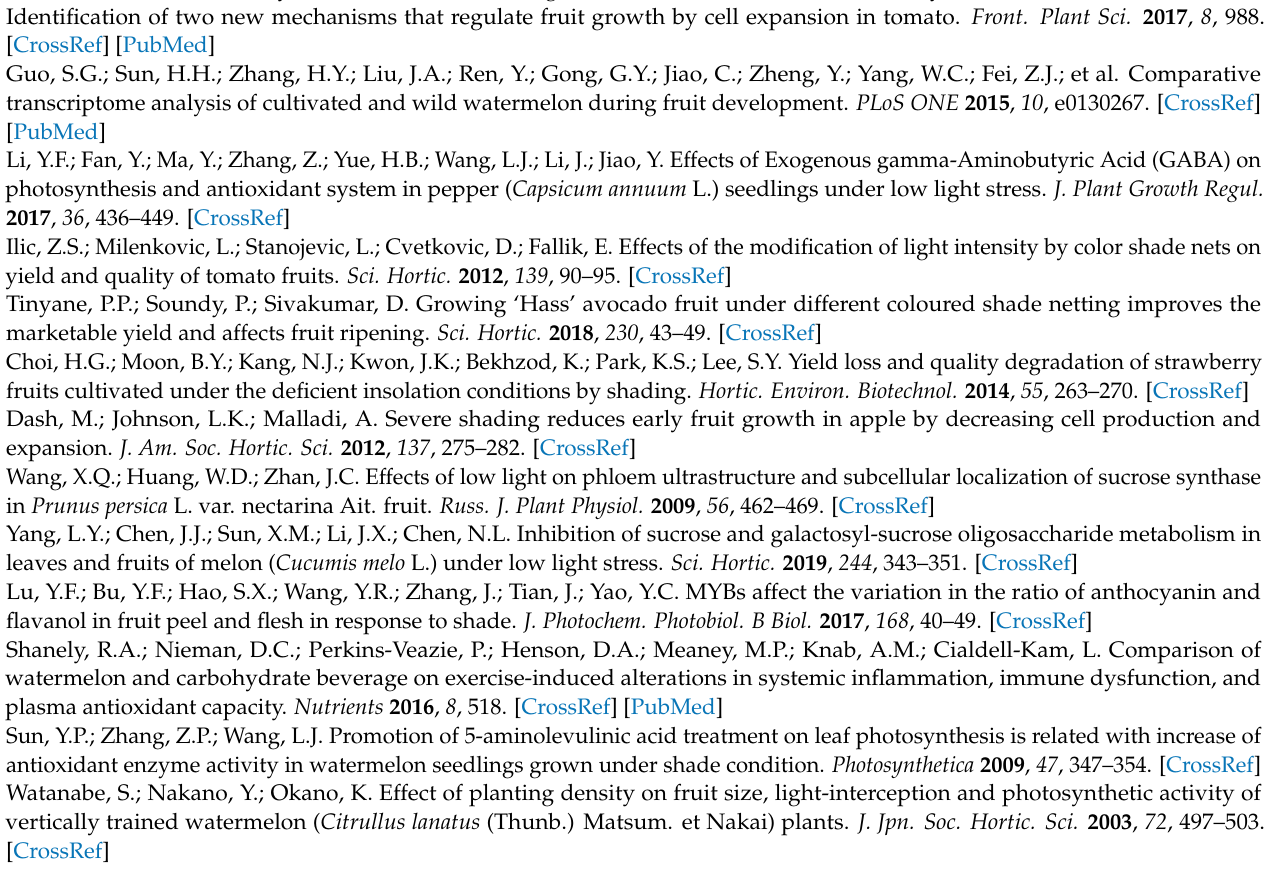
in watermelon genome were shown as blue bars and red bars (P < 0.01 and FDR < 0.05), respectively. Figure S5: The raw FPKM values of TF DEGs were first normalized by logarithmic method and a heat map was constructed to show the different expression profiles by the Heml software (version 1.0, http://hemi.biocuckoo.org/. accessed on 9 July 2020). X -axis, samples; Y -axis, differentially expressed gene names. (a) BHLH, (b) ERF, (c) NAC, (d)